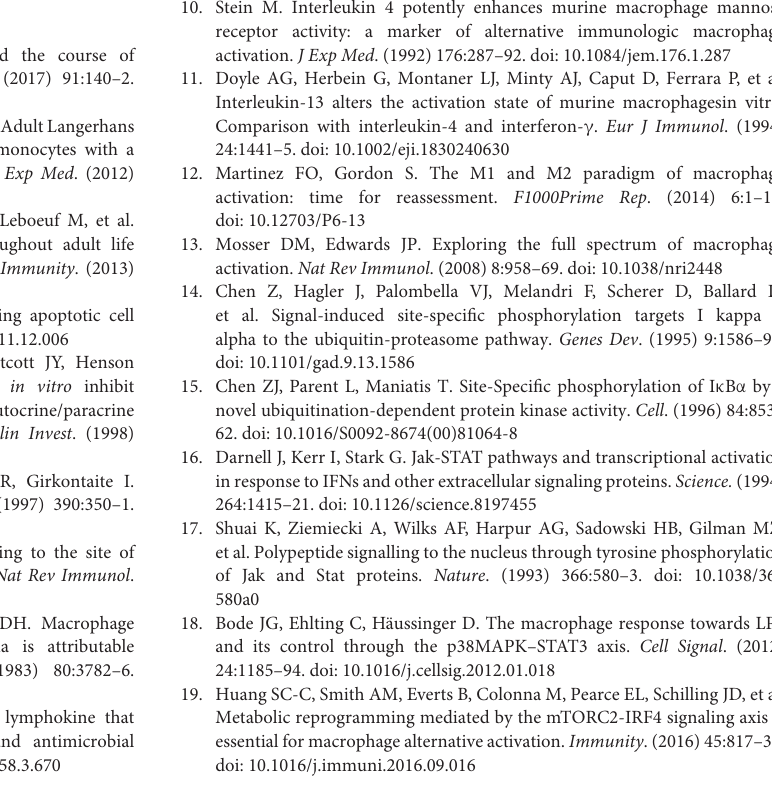
( Figure 3 ). Information from studies on inflammation-linked diseases is teaching us that pathological immune response might be underpinned by aberrant metabolic rewiring (145, 179, 180). Several metabolic products play important roles as signaling mediators, affecting not only macrophages but also neighboring cells, thus representing interesting targets for therapeutic strategies (181). To this aim, it is fundamental to understand the interplay between metabolism and immunity for the acquisition of specific functions. On the